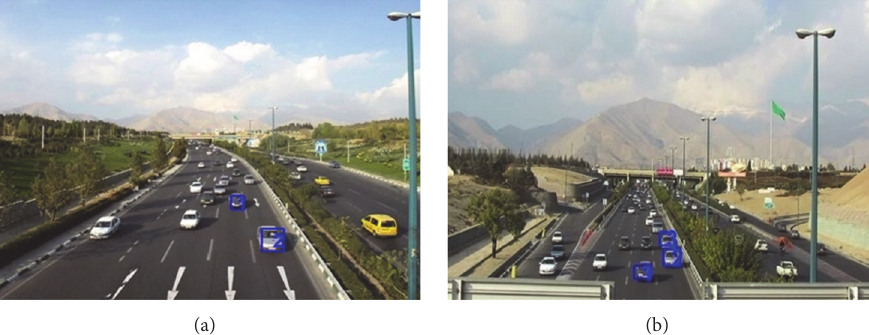
Figure 6: A sample from simultaneous selection of the vehicles in video analysis in order to measure the vehicle speed ((b) first camera (upstream) and (a) second camera (downstream)).